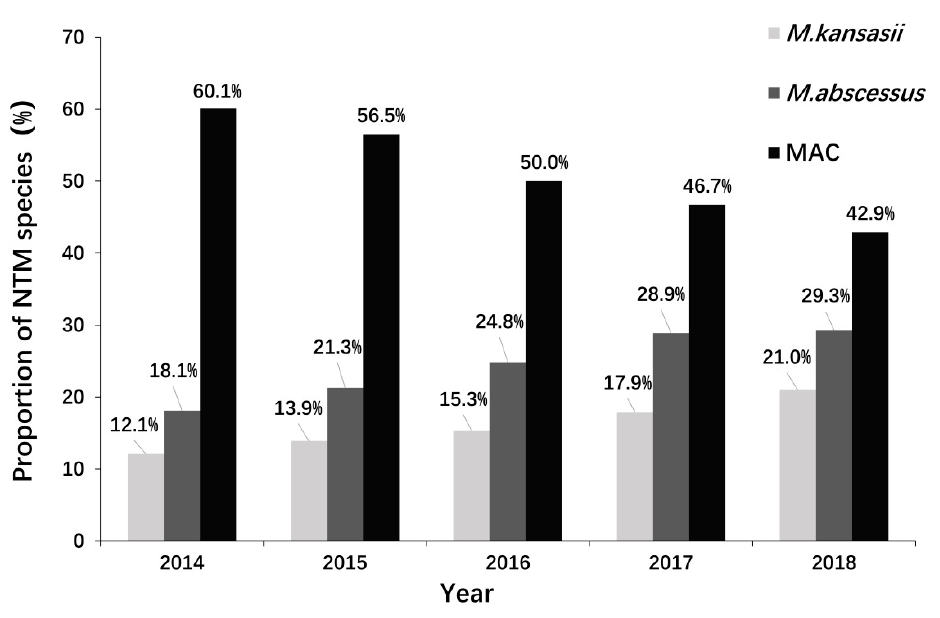
Figure 3. Changes in the abundances of major NTM species in patients with NTMPD from 2014 to 2018. NTM: nontuberculous mycobacteria, MAC: Mycobacterium avium complex.